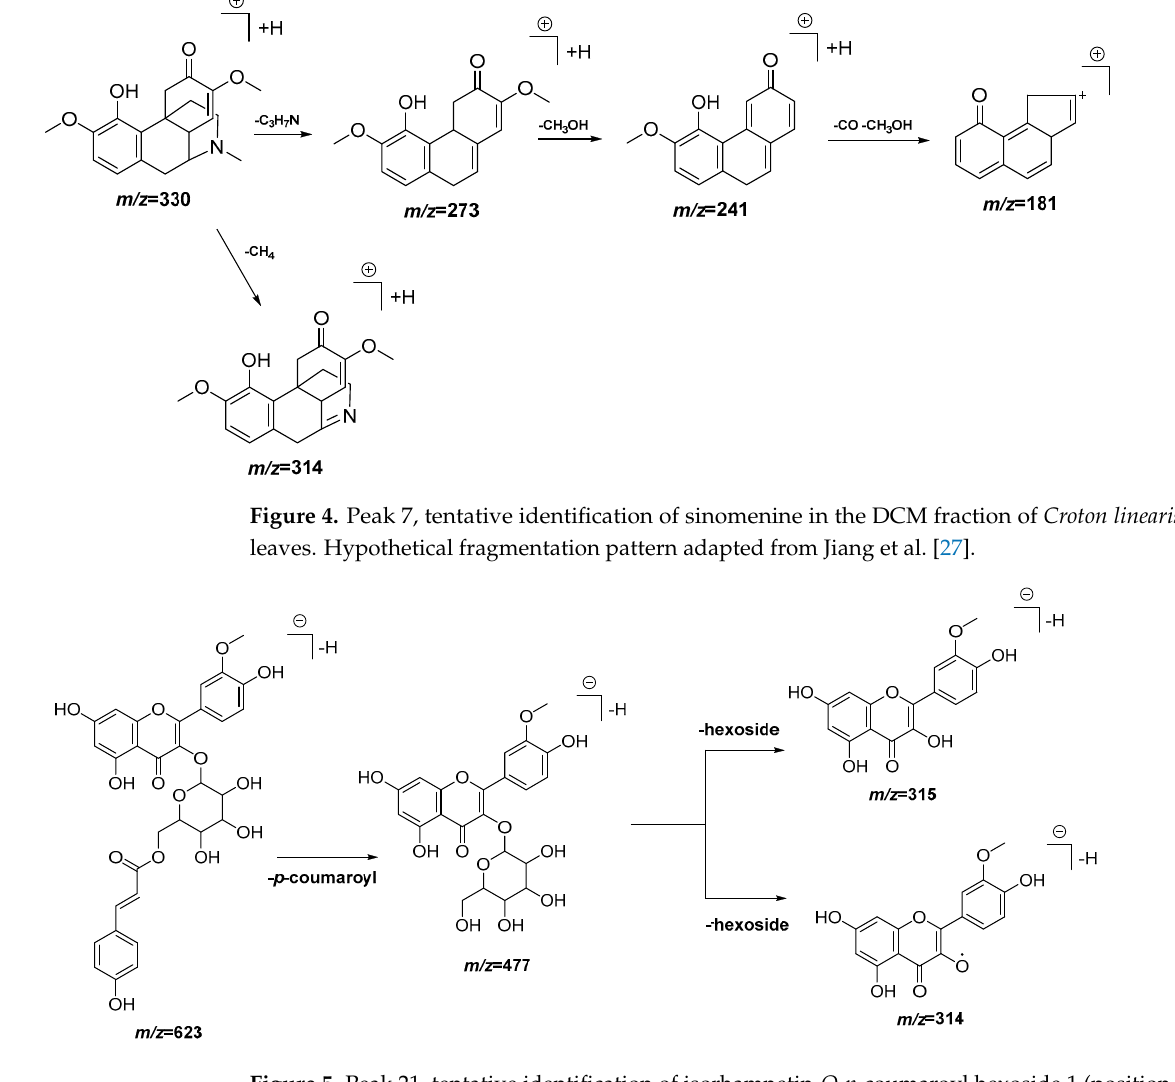
Figure 5. Peak 21, tentative identification of isorhamnetin- O-p -coumaroyl hexoside 1 (position of the substituents is arbitrary) in the DCM and EAF fractions of Croton linearis Jacq. leaves. Hypothetical fragmentation pattern adapted from Panighel et al., 2015 [28].